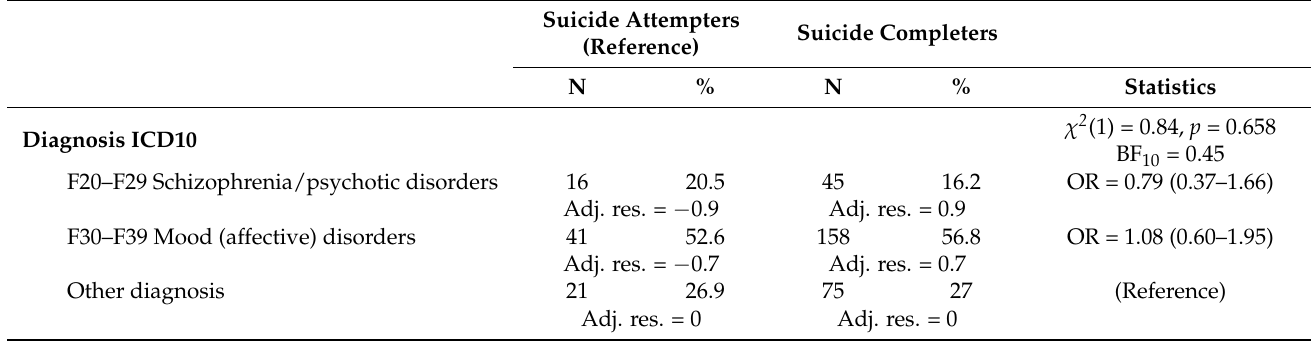
Table 2. Diagnoses of suicide attempters and suicide completers.